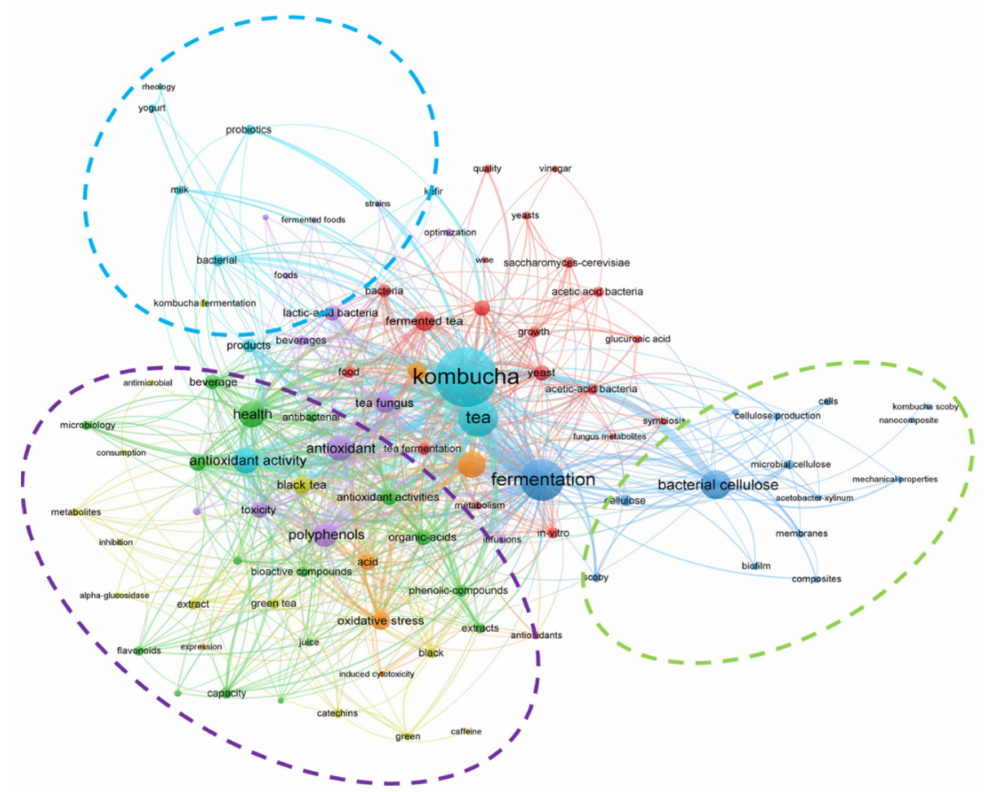
Figure 1. Co-occurrence analysis of the data from Web of Science obtained for “Kombucha” records. Bubble size presents the number of papers in the database. Bubble proximity presents frequency of co- occurrence of phrases in the same papers. The green circle represents bacterial cellulose cluster; blue circle represents probiotic potential and application of SCOBY strains in new products, while purple circle represents health-benefits of Kombucha. Due to numerous interactions, the microbiological cluster (red lines) was not clearly